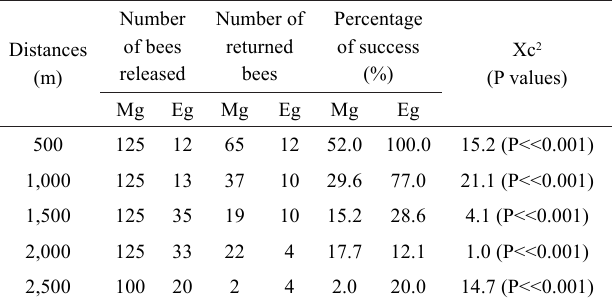
Table 1. Comparison between the number of bees released and re- turning success of the bees (as well the percentage of success) for the two groups of Melipona mandacaia bees (“mixed group” and “experienced group”), and statistical analysis (χc2 and P values, Chi- square test), for the different